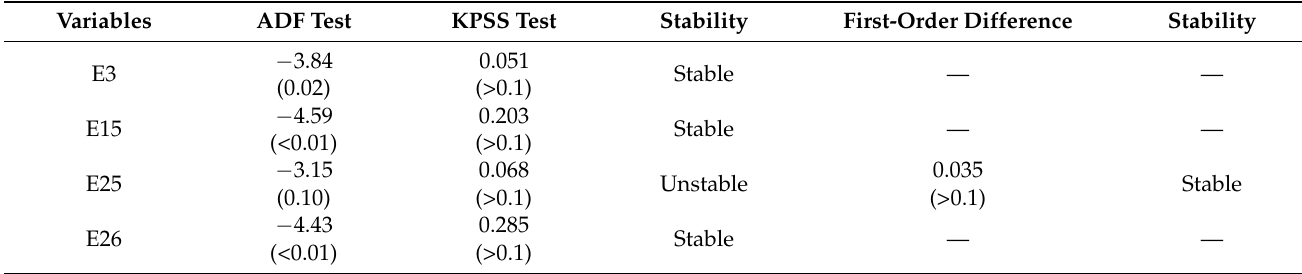
Table 5. Results 1 of the unit root test on panel data.